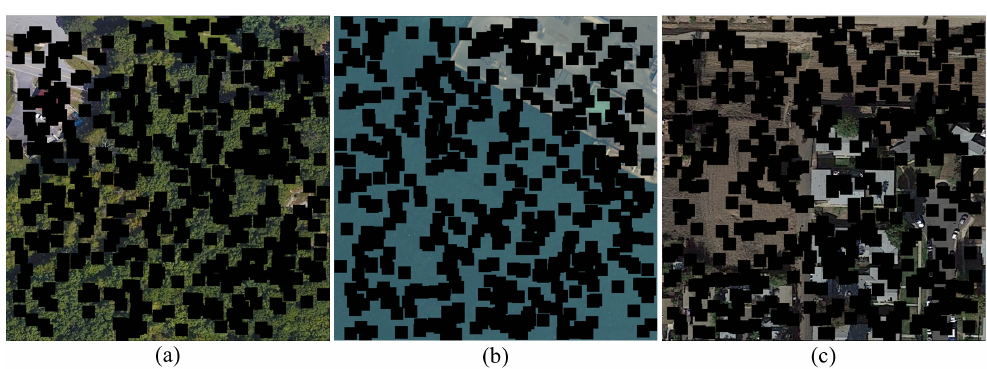
Figure 2. Randomly mask the presentation of r number of m × n small rectangles on the FAIR dataset. ( a – c ) are visualizations of the FAIR dataset after random masking